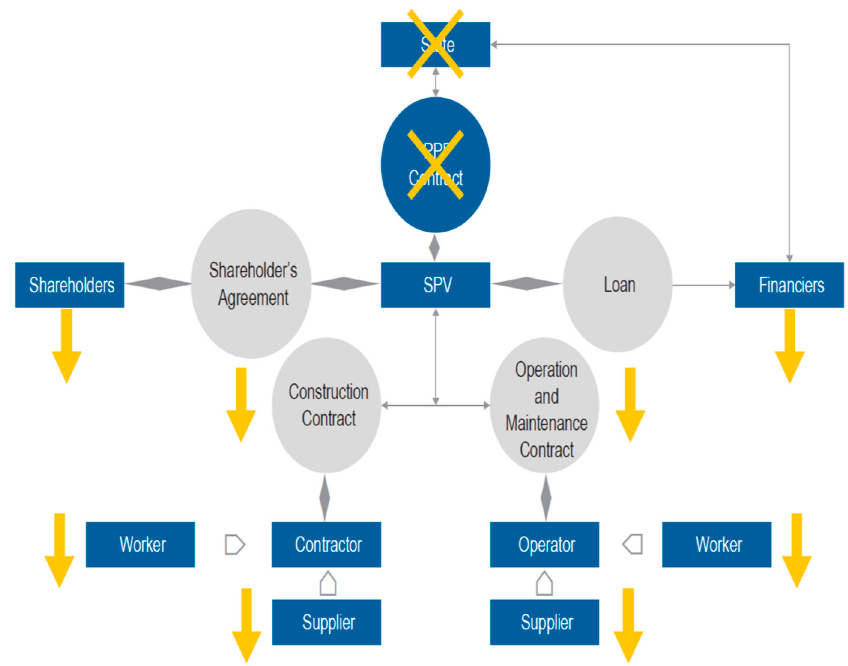
Figure 6. Contractual chain. Source: Heydari et al. [7].